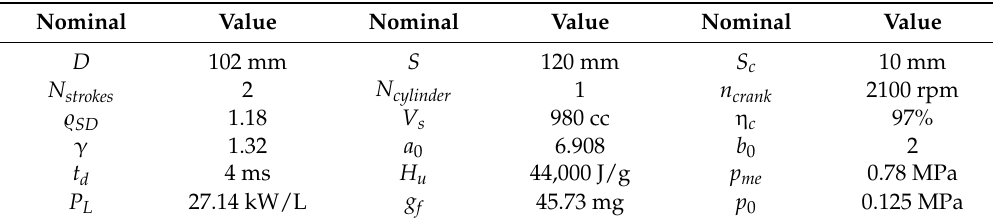
Table 4. ICE specifications.